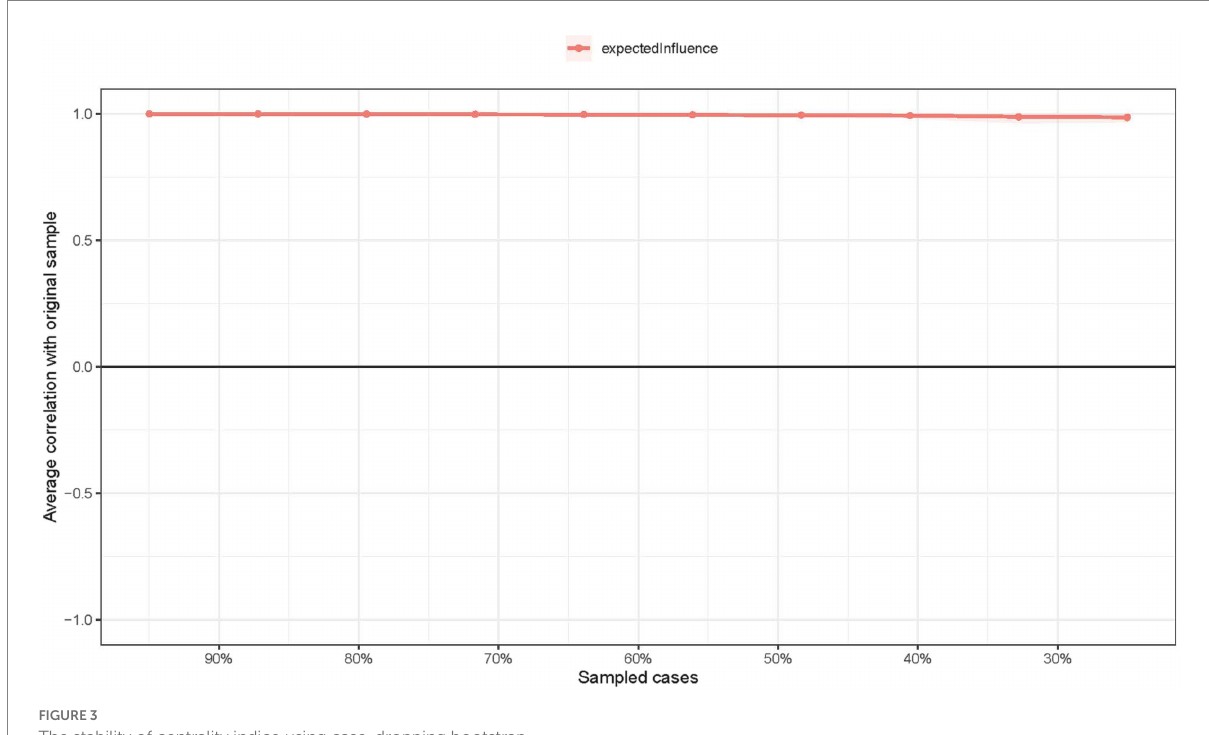
FIGURE 3 The stability of centrality indice using case-dropping